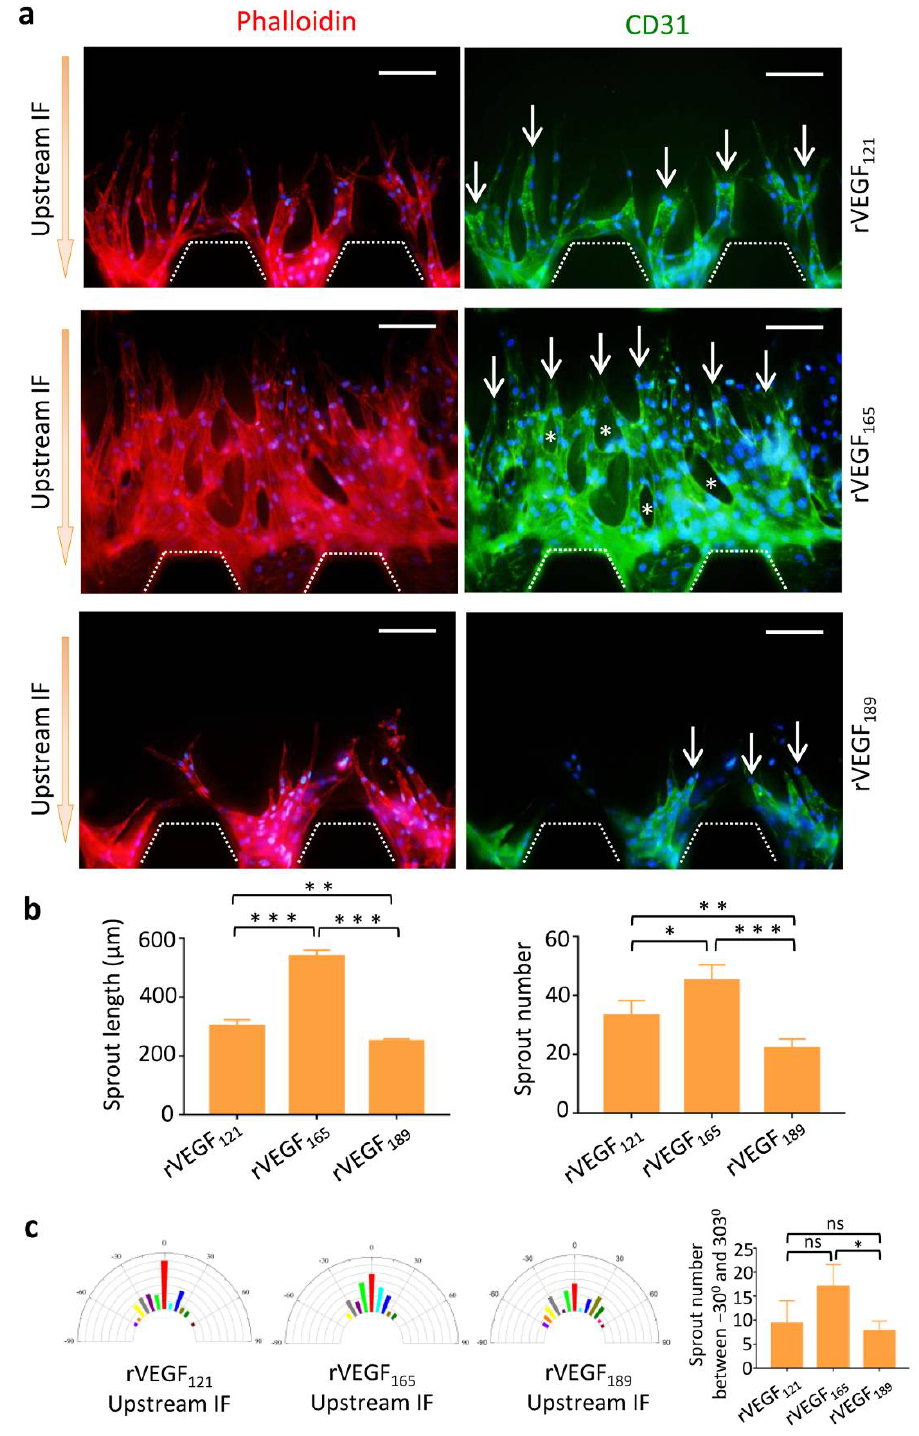
Figure 4. Morphologies of vascular sprouts induced by rVEGF 121 , rVEGF 165 , and rVEGF 189 . ( a ) Images of vascular sprouts induced by rVEGF 121 , rVEGF 165 , rVEGF 189 in the presence of up- stream IF. rVEGF 165 induced increased numbers and longer sprouts (arrows) compared to rVEGF 121 and VEGF 189 . Vessel loops (*) could be observed between the sprouts in VEGF 165 . ( b ) Quantitative analyses of angiogenesis in terms of average sprout length and number. ( c ) Semicircular histograms showing the distribution of orientation angle of vascular sprouts stimulated by rVEGF 121 (left), rVEGF 165 (middle left), and rVEGF 189 (middle right) with the upstream IF. Quantitative analyses of sprout orientation (right). Scale bar = 100 µ m. * p < 0.05, ** p < 0.01, *** p <